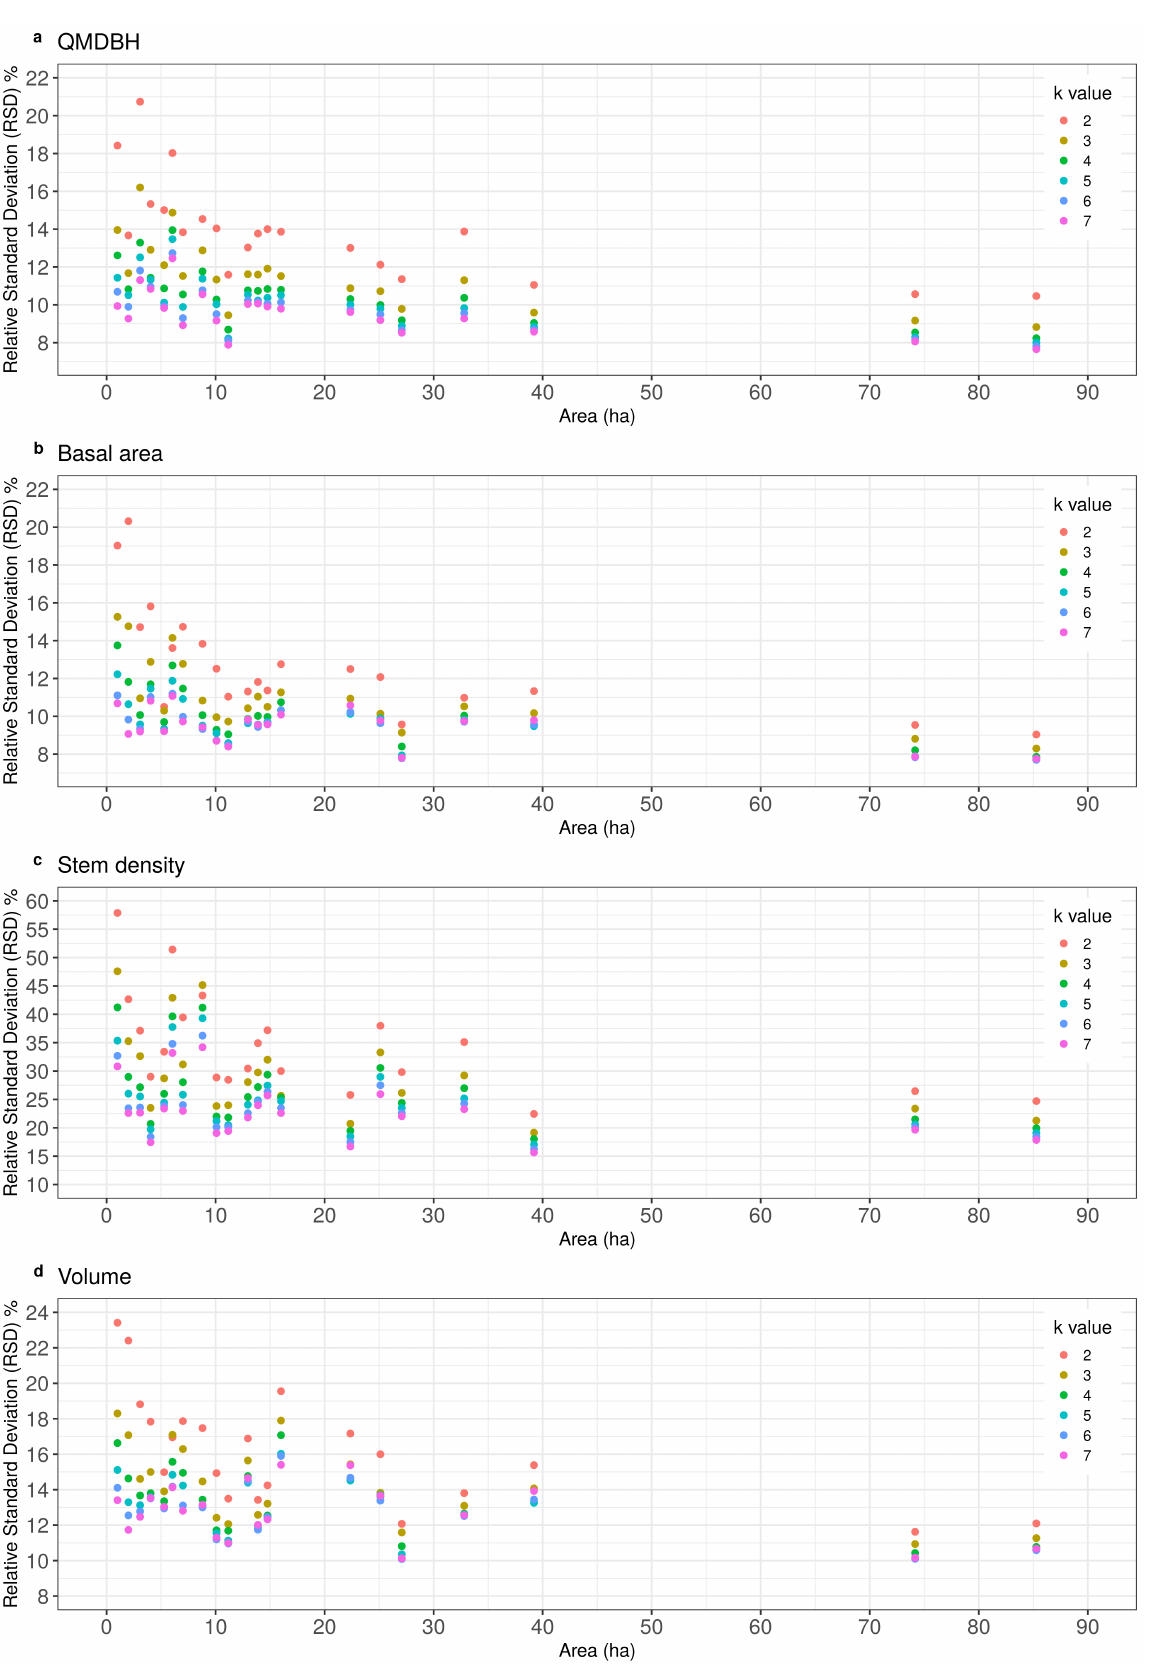
Figure 6. Relative Standard Deviation (RSD) for ( a ) QMDBH, ( b ) basal area, ( c ) stem density, and ( d ) volume for k values between 2 and 7 and a range of